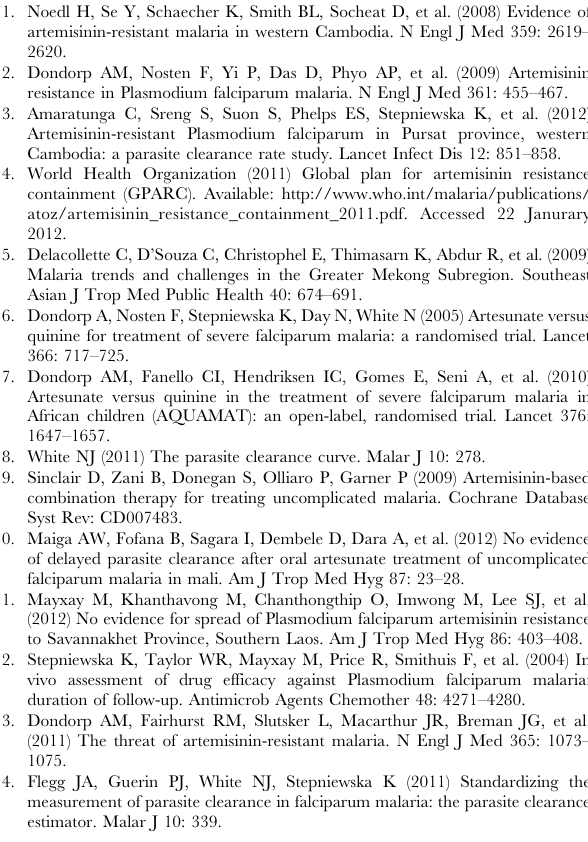
Figure S5 Plasma concentration-time curve of artesu- nate (Panel A) and DHA (Panel B) in participants with (dashed line) and without (solid line) persistent parasit- emia 72 hours after artesunate